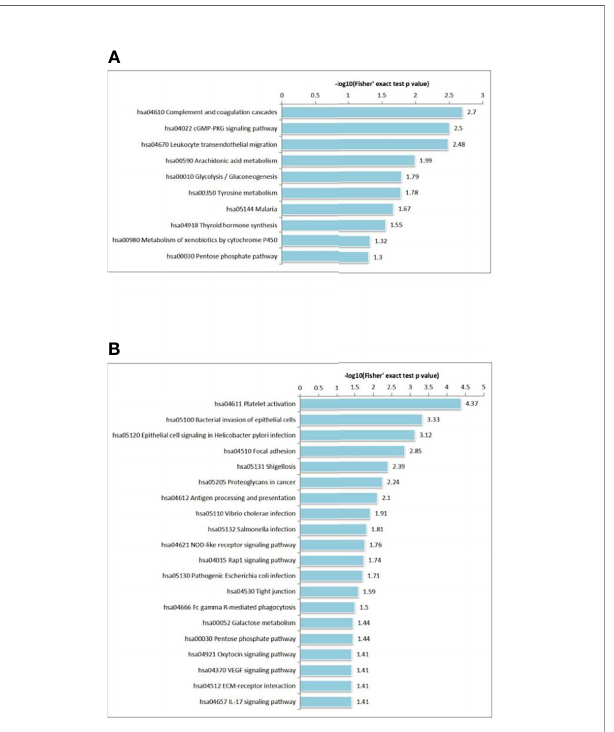
FIGURE 5 | KEGGpathway-basedenrichmentanalysisofDEPs (A) andDPPs (B) .